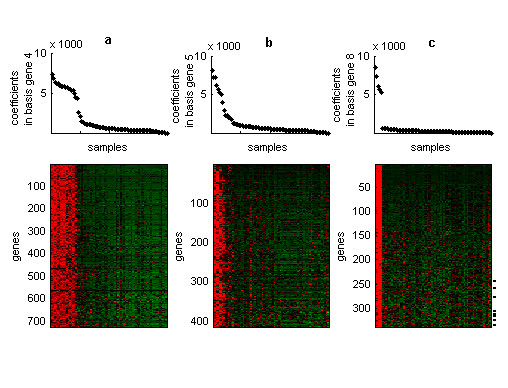
Structures from the human transcriptome dataset Plots in the first row represent coefficients of samples in the (a) fourth, (b) fifth and (c) eighth sorted basis genes. Heatmaps in the second row represent the expression matrix in which genes (in rows) and samples (in columns) are sorted by their coefficients in the corresponding basis experiment and basis gene. Only genes that were highly representative of each basis experiment are shown. Dash lines in the third heatmap represent positions of genes that were included in the testis-gene module but were clustered in distant positions to the testis-gene group by hierarchical clustering.